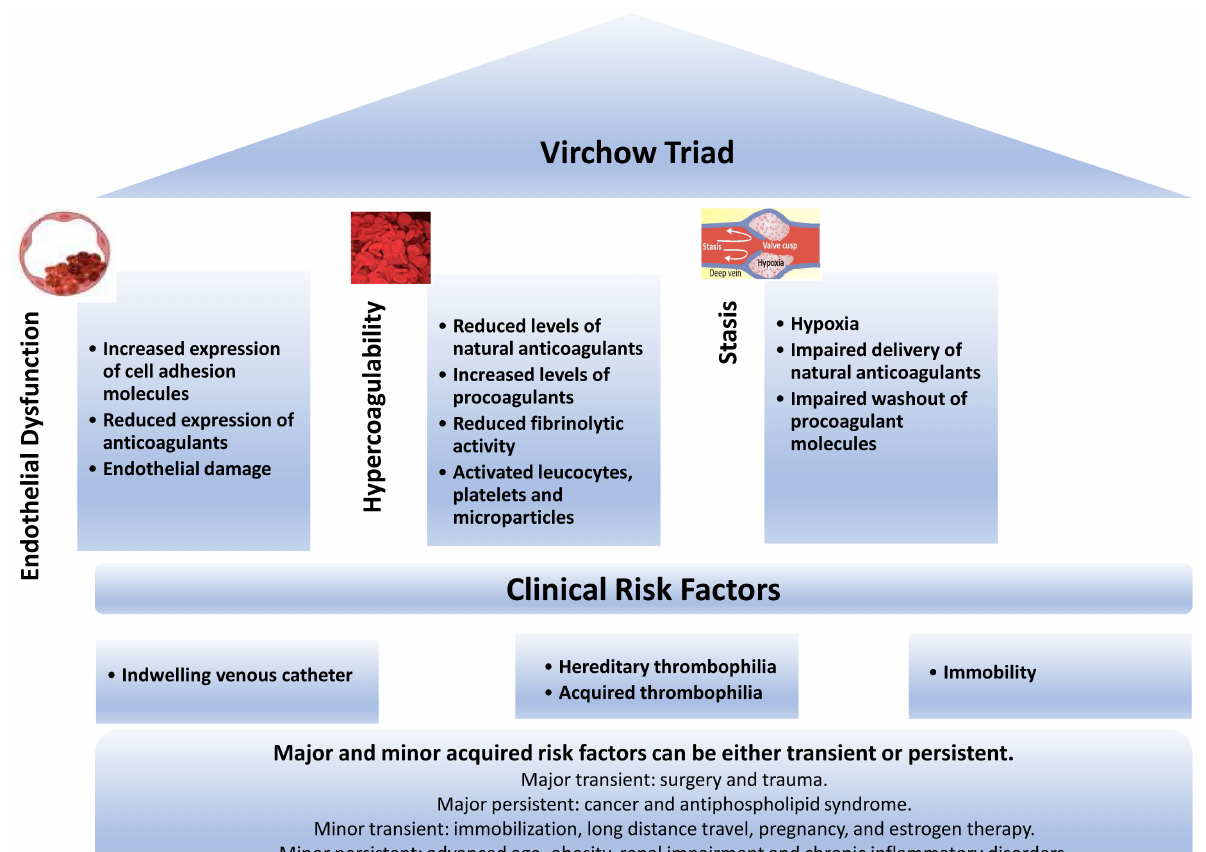
Figure 1. Pathogenesis of venous thromboembolism and risk factors.